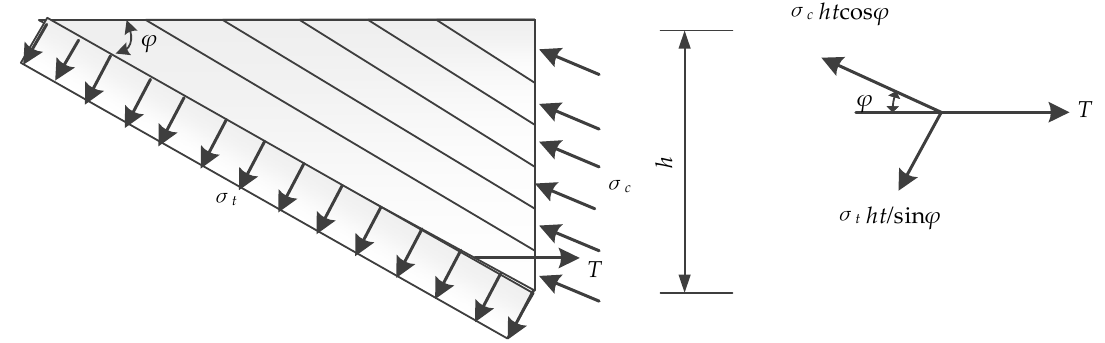
Figure 9. Right isolation body for Truss Model.